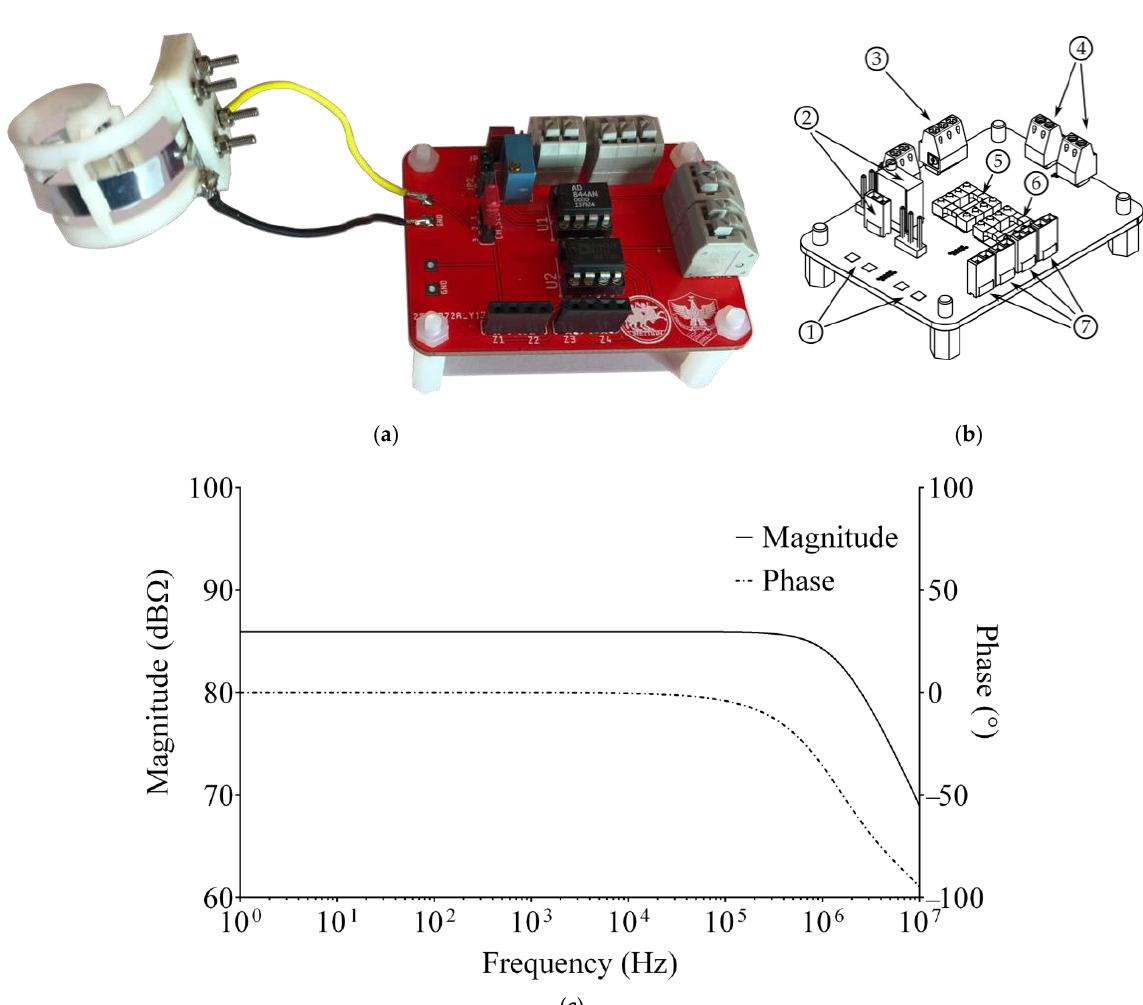
Figure 9. The electronic interface: ( a ) the fabricated prototype and ( b ) highlights of its components: (1) PVDF sensor inputs, (2) TIA gain regulation section, (3) supply voltage input, (4) interface outputs, (5) channel 1 VCII, (6) channel 2 VCII, and (7) filter configuration pins. ( c ) Simulated frequency behavior of the VCII-based transimpedance amplifier.